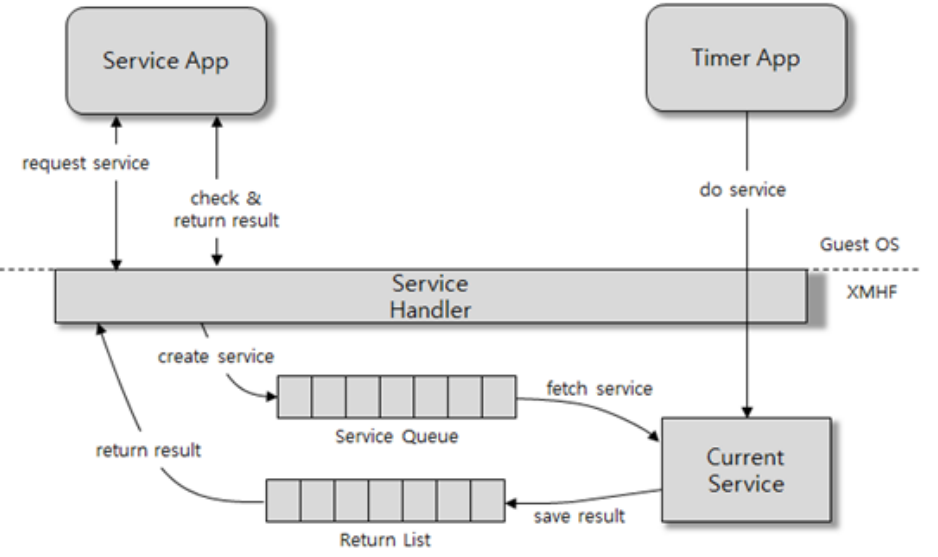
Figure 6. Components and service flows in the implementation.